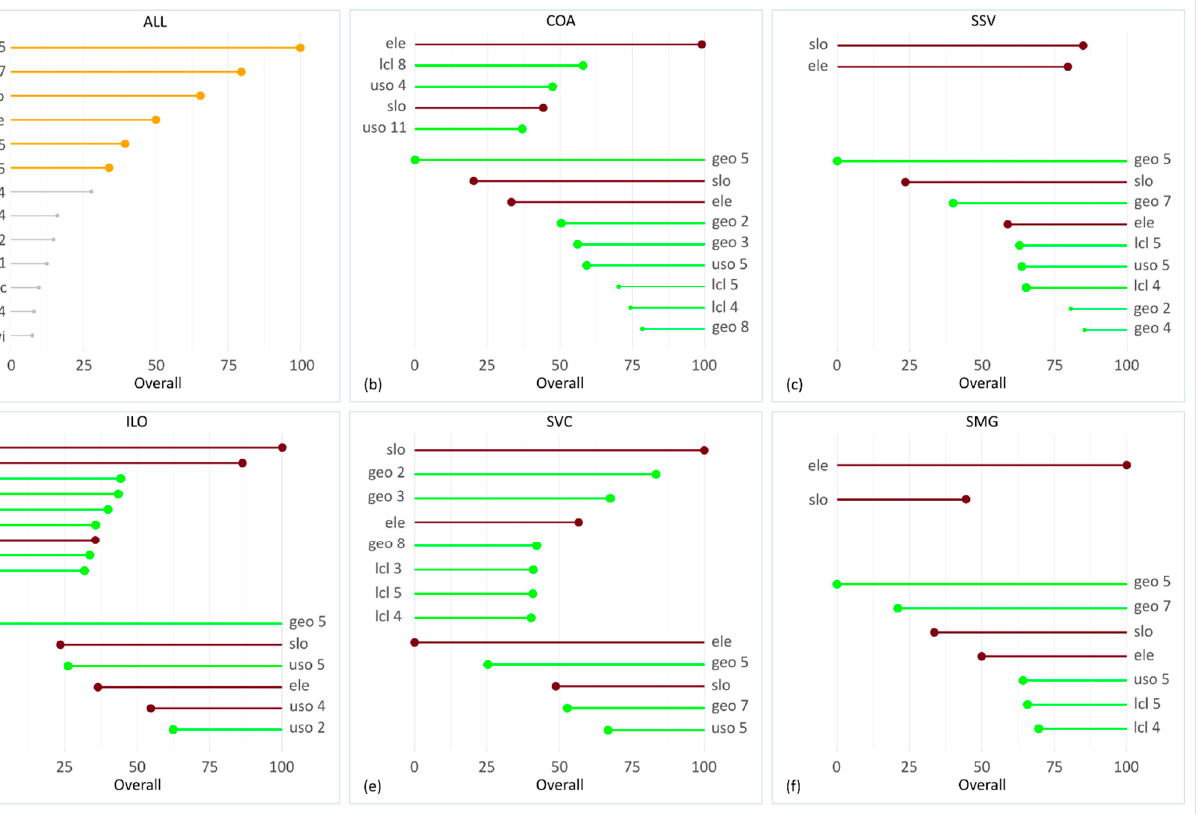
Figure 5. The most important variables for the ALL model ( a ) and the LOC (left side) and the OLO (right side) models ( b – f ). The common variables for the LOC and the OLO models are presented in amaranth, while the different variables are presented in green. Thin lines are used for variables with a lower overall (minor than 30 out of 100). Here are the acronyms used: geo 2 = soft rock; geo 3 = hard rock; geo 4 = medium rock; geo 5 = very soft soil; geo 6 = soft soil; geo 8 = medium soil; lcl 3 = valleys; lcl 4 = plains; lcl 5 = open slopes; lcl 8 = midslope ridges; uso 2 = forest; uso 4 = crop and pasture; uso 5 = permanent crop; uso 11 = shrub vegetation.